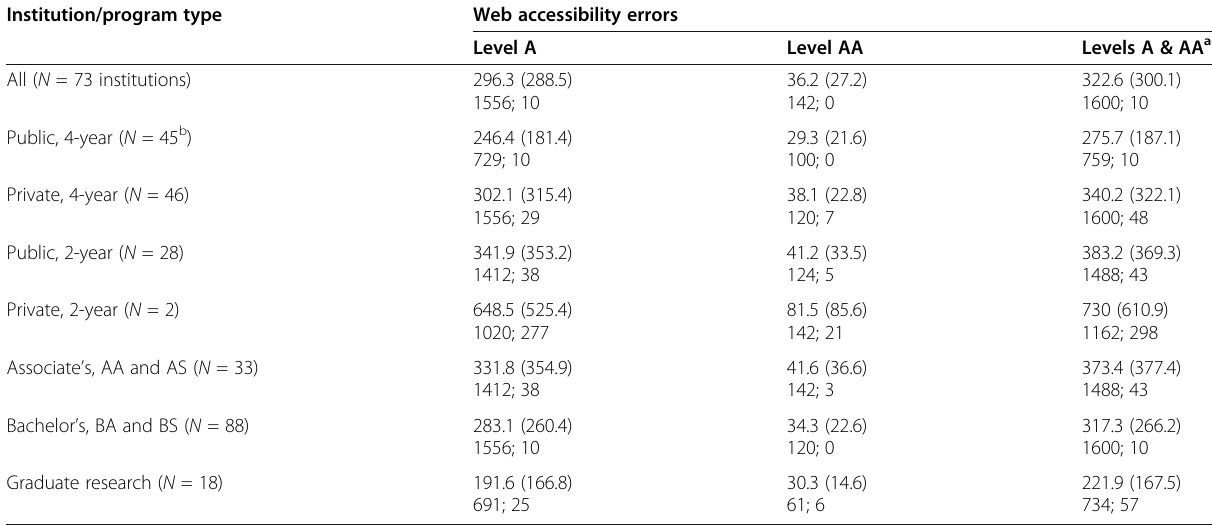
Table 3 Descriptive statistics of web accessibility errors ( N = 44,241) of physics curriculum webpages disaggregated by institution type and program type. Note: The cells are formatted as mean (standard deviation) with the high; low in the second line Institution/program